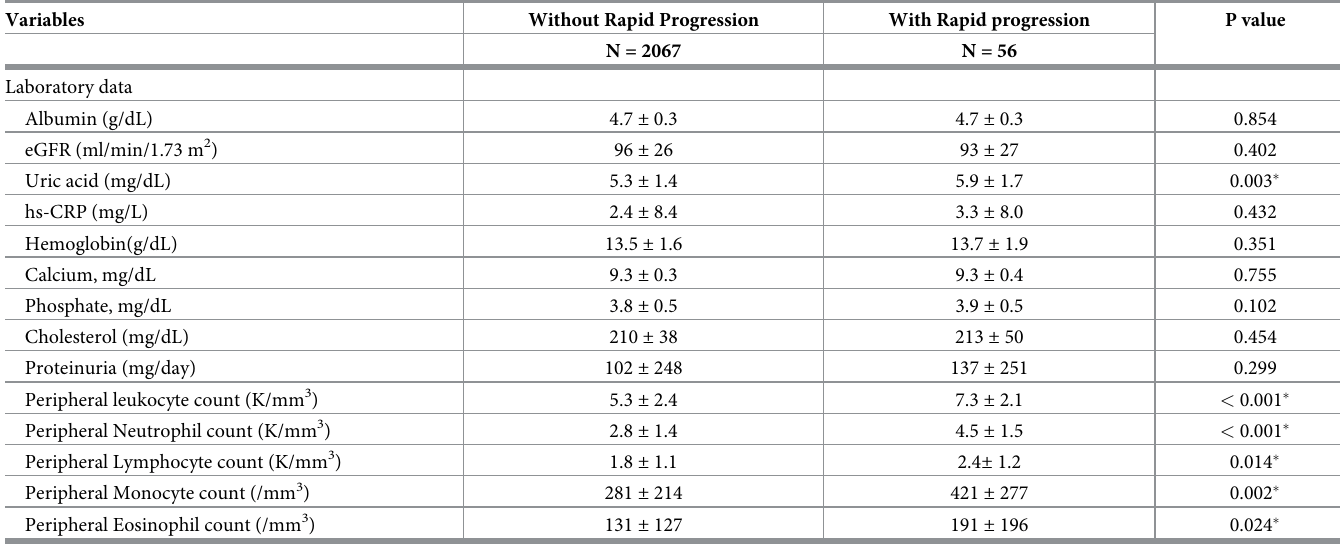
Table 5. Laboratory data of study population with and without rapid progression of kidney.